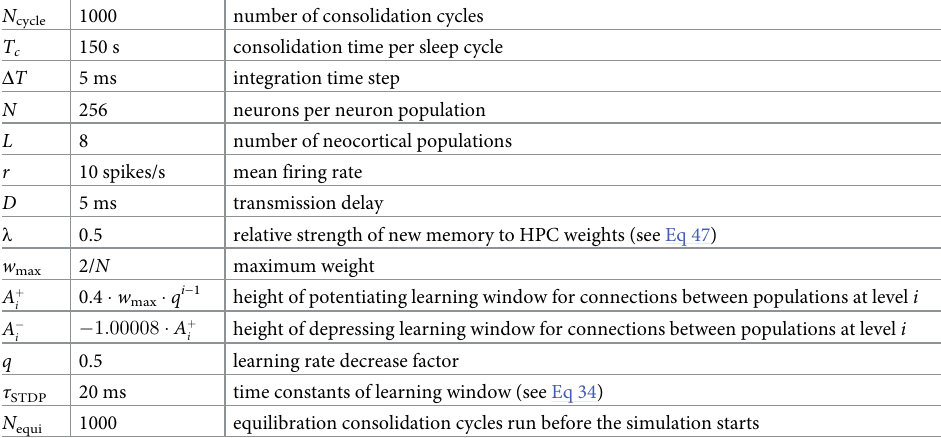
equilibration consolidation cycles run before the simulation starts